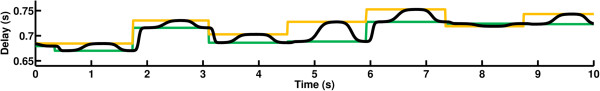
The bold curve shows the dynamically changing delay during a sequence of several strides. Values of mICdelay and mTOdelay are indicated by horizontal green and orange line segments respectively.